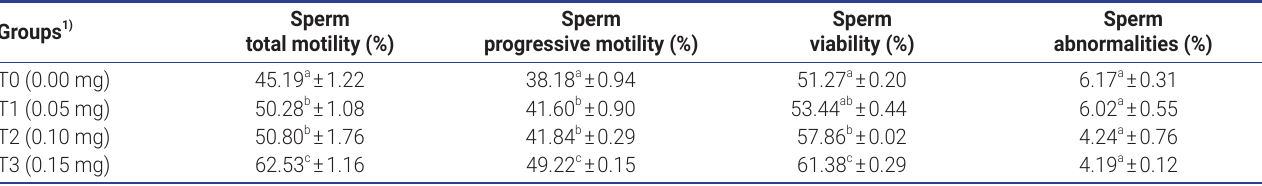
Sperm total motility (%)